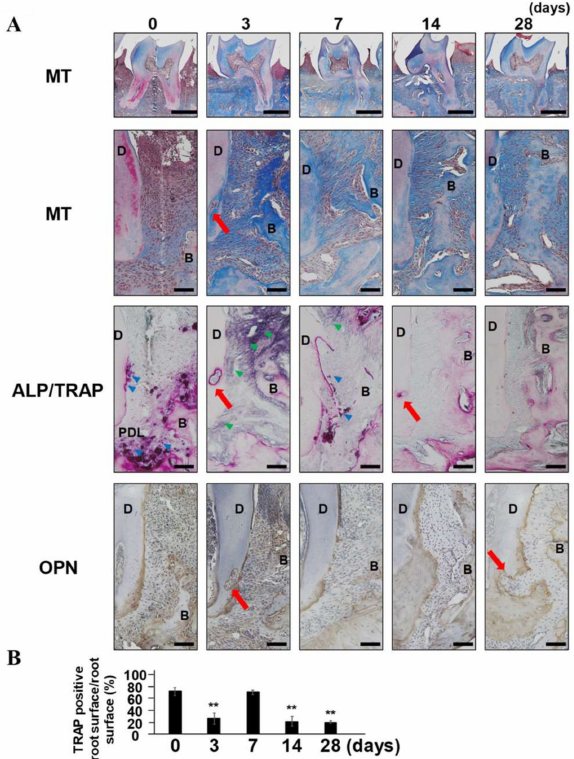
Figure 2. Cementum remodeling and external root resorption in the murine periodontal tissue regeneration model. ( A ) Demineralized male maxilla sections collected on days 0, 3, 7, 14, and 28 were stained with TRAP/ALP double staining, Masson’s trichrome, and α -OPN. Scale bars correspond to 500 and 100 µ m at low and high magnification, respectively. ( B ) The distance of TRAP- positive area along with root surface was normalized by total distance of root surface ( n = 3) and the ratio was comparatively evaluated. ** p < 0.01 significantly different from day 0. MT = Masson’s trichrome staining. PDL = periodontal ligament tissue, C = cementum, D = dentin, B = bone, P = pulp. Red arrows indicate an external dentin-absorbed